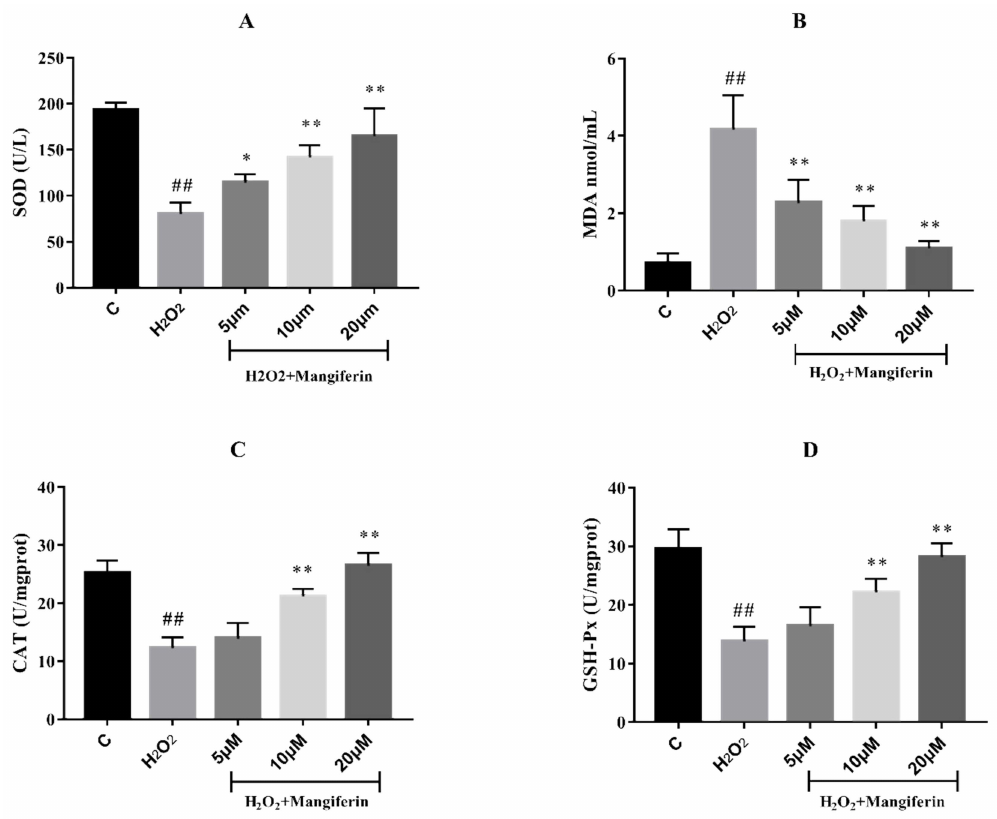
Figure 2. The anti-oxidative e ff ect of mangiferin on H 2 O 2 induced H9C2 cells. ( A ) SOD activity, ( B ) MDA content, ( C ) CAT activity, ( D ) GSH-Px activity. ## p < 0.01 versus the control; * p < 0.05 and ** p < 0.01 versus the H 2 O 2